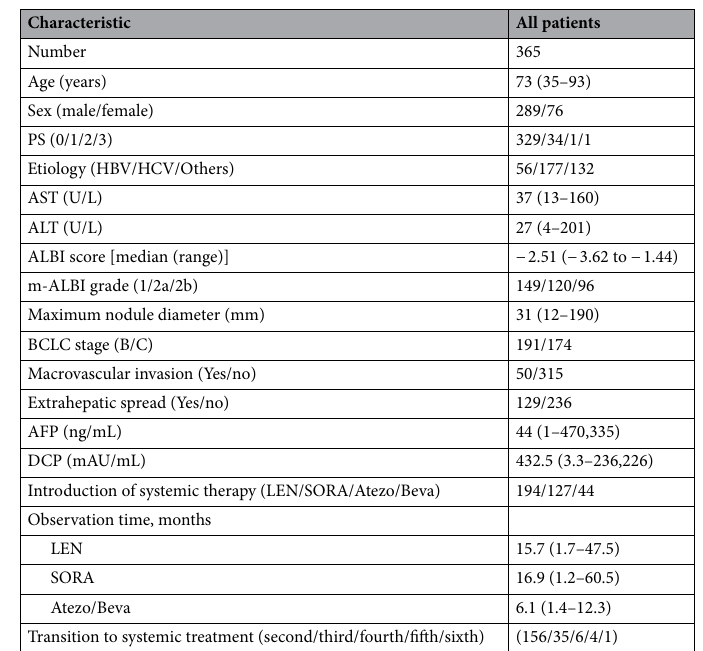
Table 1. Patient characteristics. Data are expressed as median (range), or number. PS, performance status; HBV, hepatitis B virus; HCV, hepatitis C virus; AST, aspartate transaminase; ALT, alanine aminotransferase; m-ALBI, modified albumin-bilirubin; BCLC, Barcelona Clinic Liver Cancer; AFP, α-fetoprotein; DCP, des-γ- carboxy prothrombin; LEN, lenvatinib; SORA, sorafenib; Atezo, atezolizumab; Beva, bevacizumab.